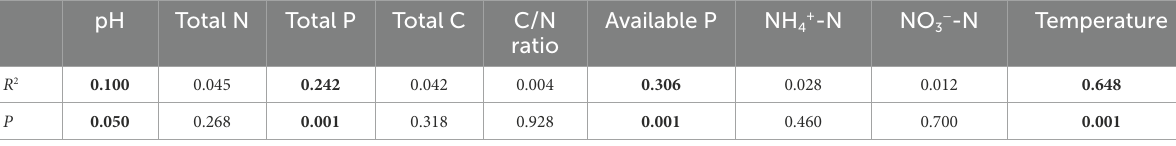
TABLE 4 Relationships between the composition of the arbuscular mycorrhizal (AM) fungal community and environmental factors revealed by Monte Carlo tests ( n =